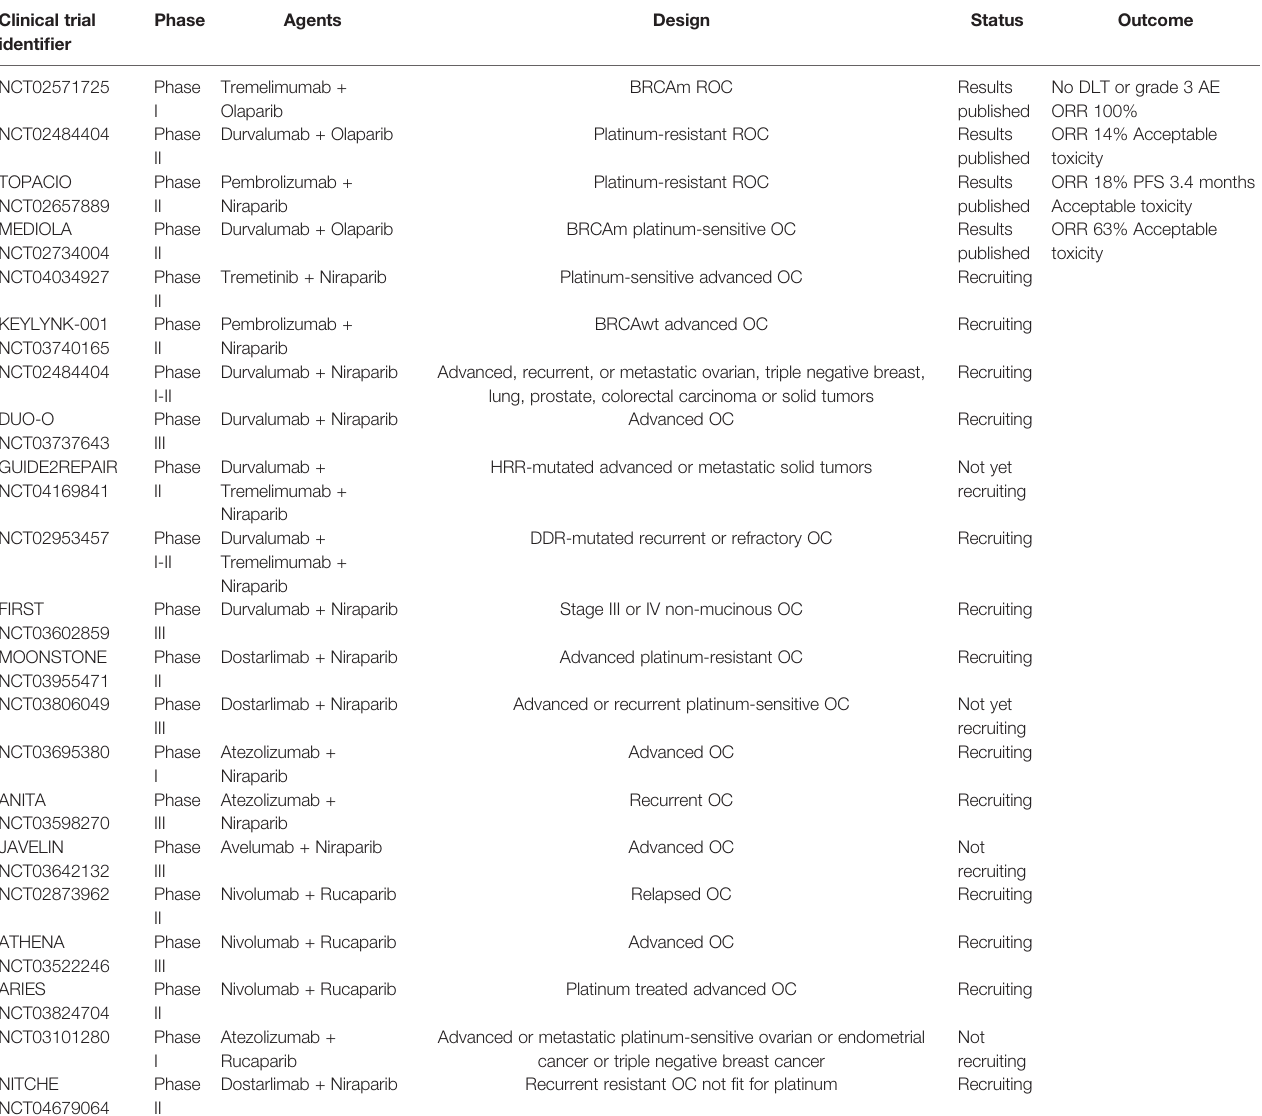
TABLE 1 | Ongoing trials regarding ICI + PARPi in ovarian cancer. Clinical trial identi fi